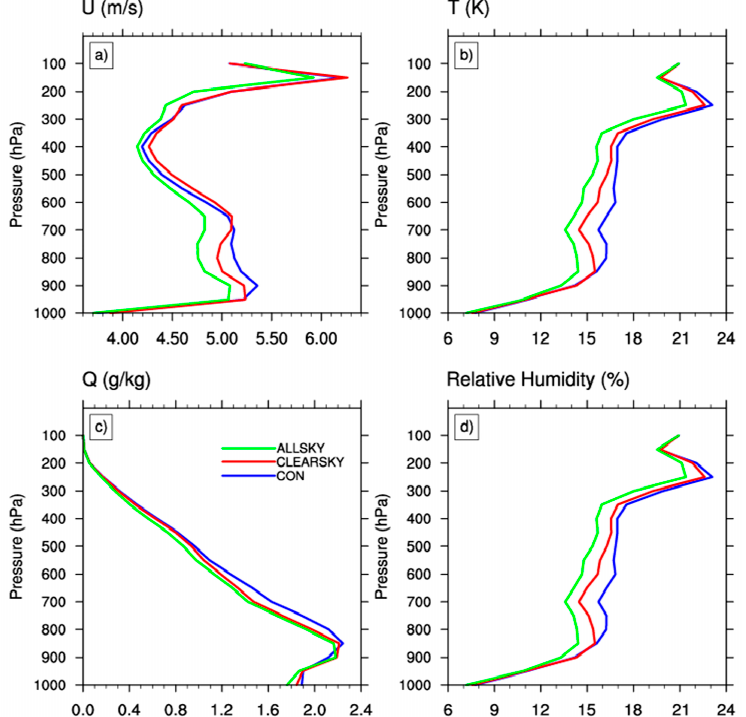
Figure 7. The averaged root-mean-square errors of analysis for the three experiments for ( a ) u, ( b ) temperature, ( c ) water vapor mixing ratio and ( d ) relative humidity.